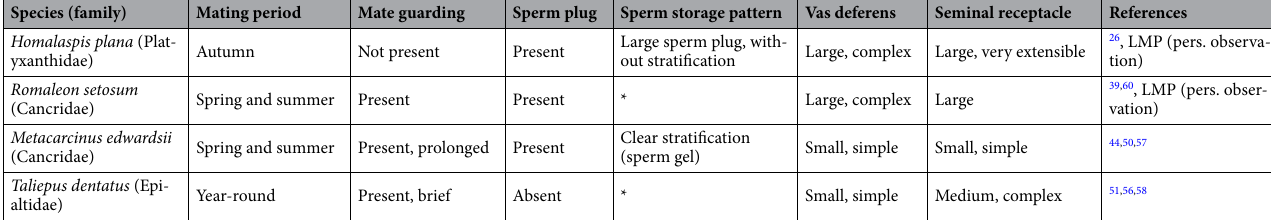
Table 1. Summary of mating tactics and size and complexity of male and female reproductive systems of the four brachyuran species studied. *Refers to not investigated